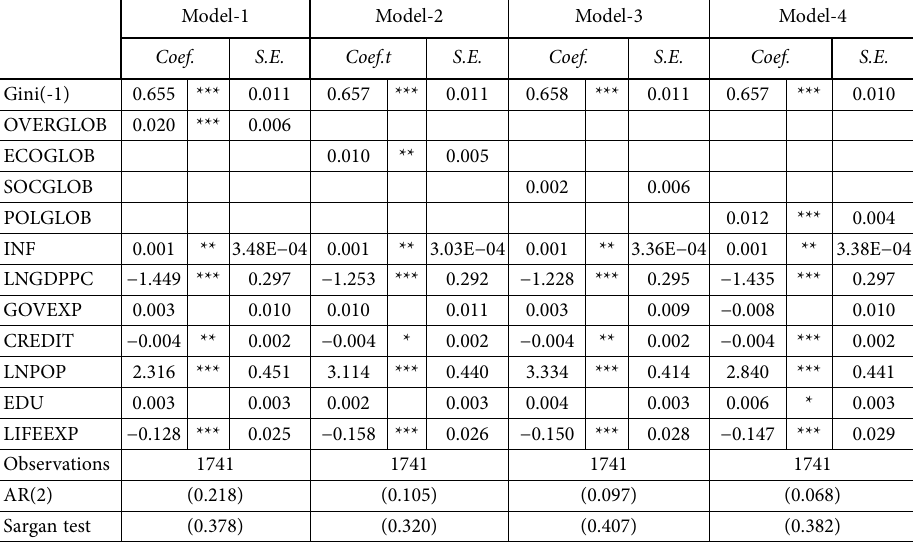
Table 1. Income inequality and globalization, dynamic GMM